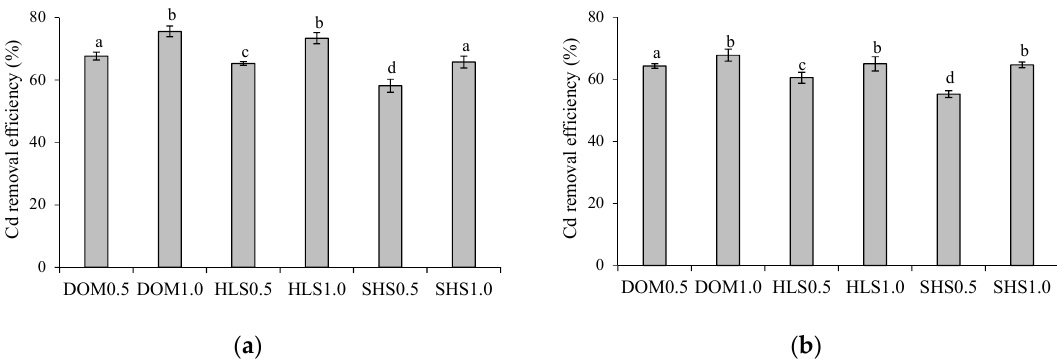
Figure 1. Cd removal efficiency in the column reactor at two flow rates (0.5 and 1.0 mL/min). The significant differences ( p < 0.05) between tested variants are marked with small letters: ( a ) S1 and ( b ) S2. Small letters mean differences between tested variants in figures.